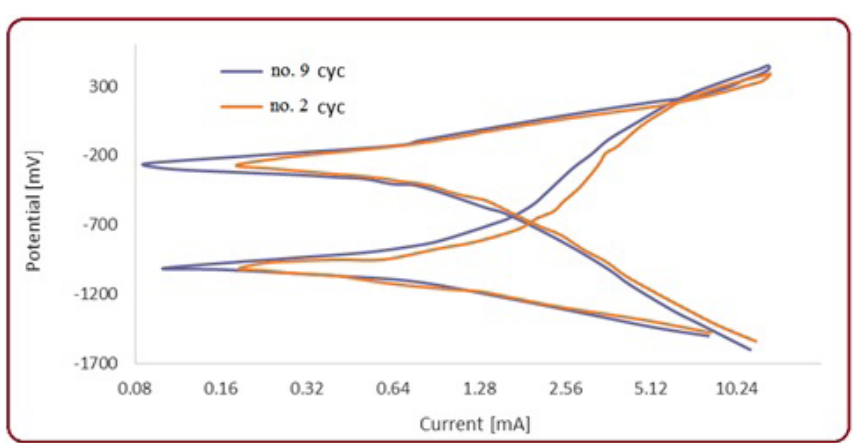
Figure 5. The cyclic test for two samples no.2 and